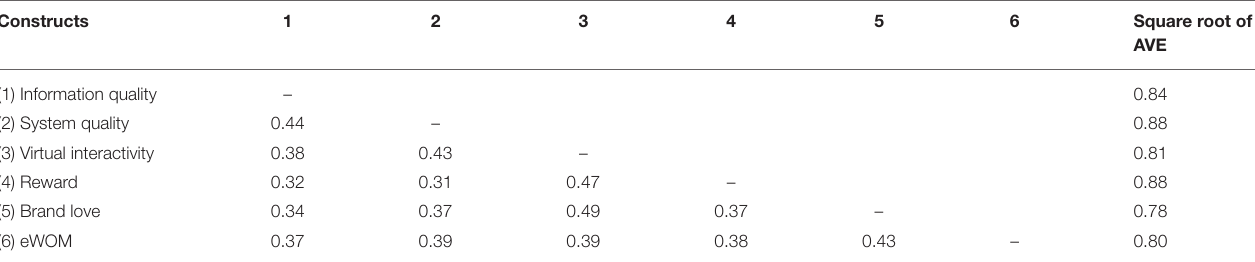
TABLE 3 | Discriminant validity.